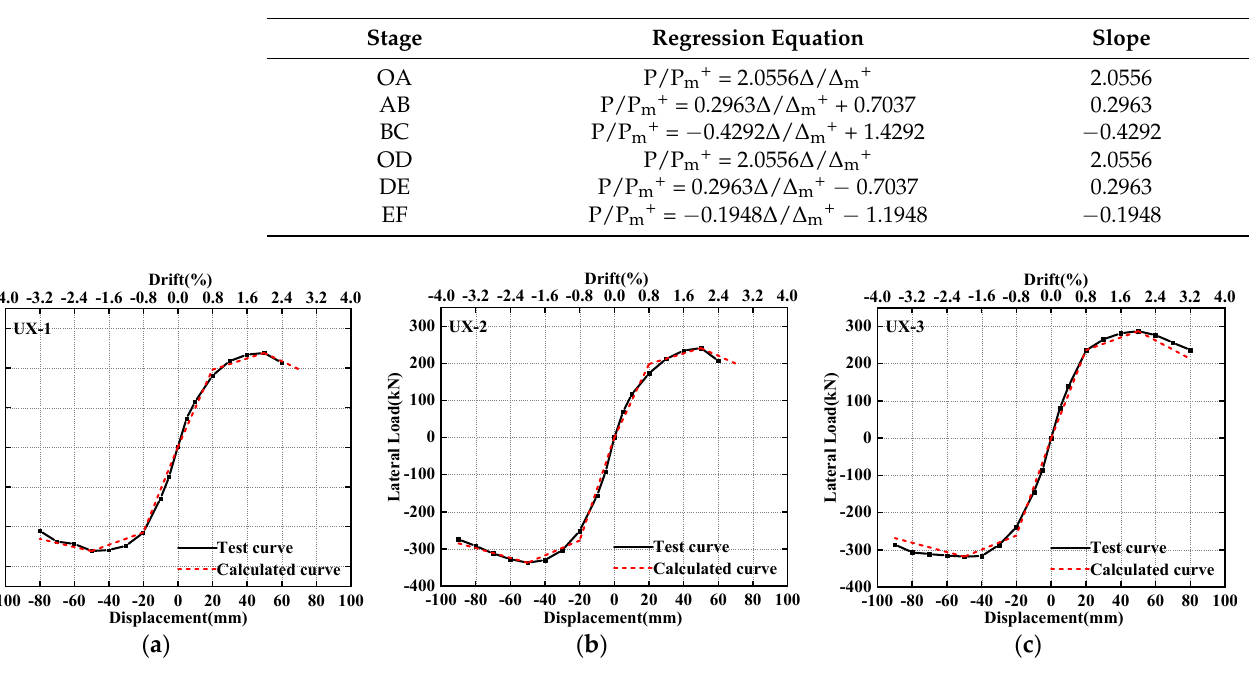
Figure 13. Comparison of skeleton curve calculation results with test results: ( a ) Specimen UX-1; ( b ) Specimen UX-2; ( c ) Specimen UX-3.